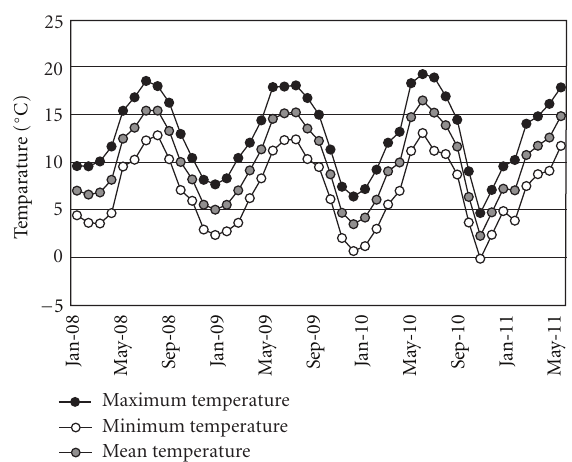
Figure 10: Air temperature reading for Johnstown Castle, January 2008 to July 2011, showing mean, maximum, and minimum tem- perature for each